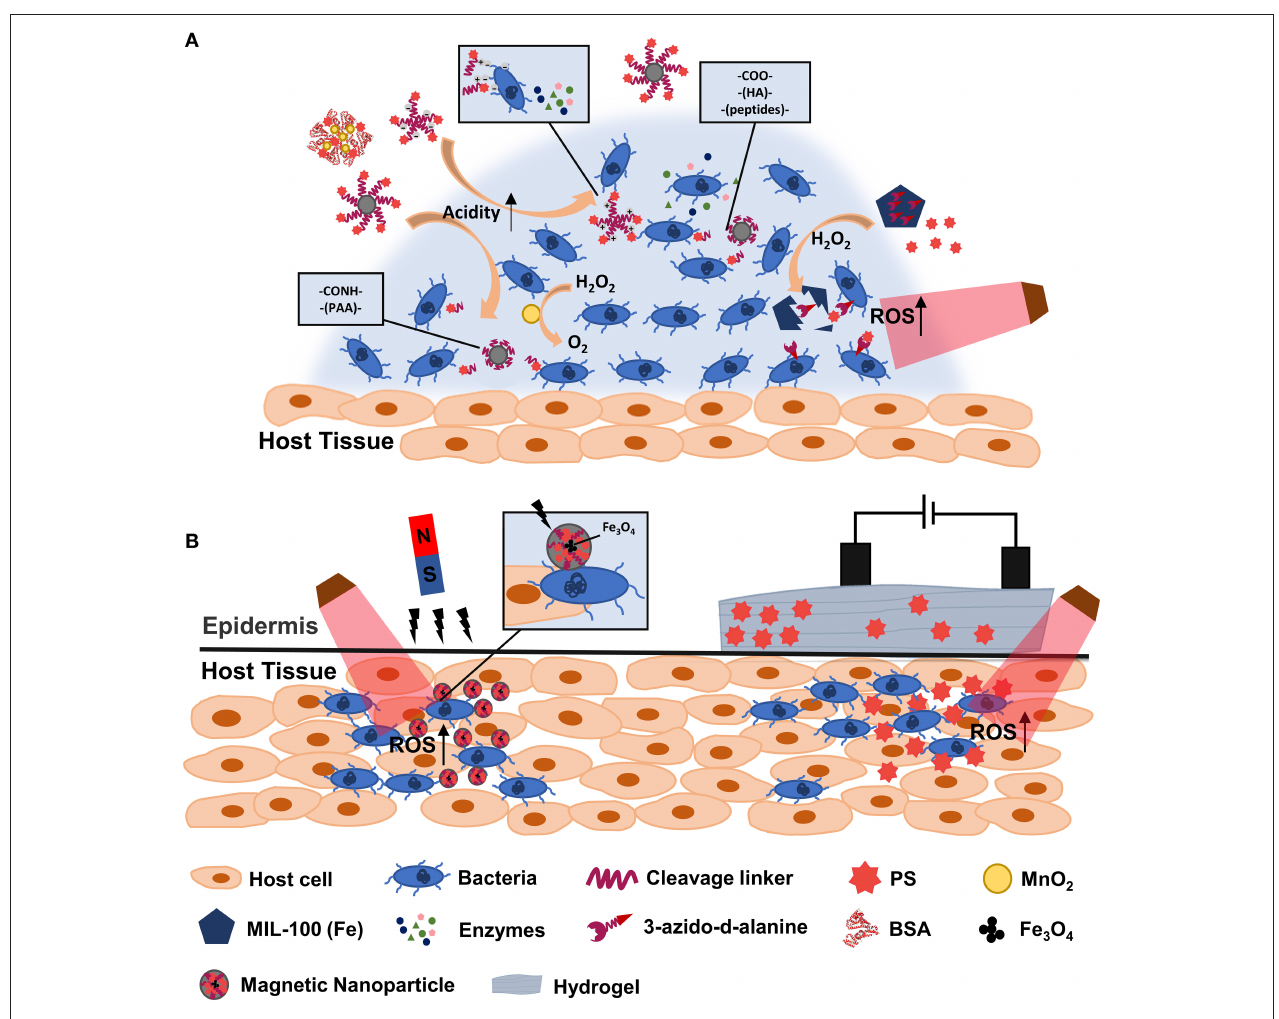
FIGURE 1 | Scheme illustration of stimuli-responsive Nanoplatforms-Assisted PDT in fighting against bacterial infections. Internal (A) and external (B) stimuli-responsive platform assisted PDT are showed. PAA, polyacrylic acid; HA, hyaluronic acid; BSA, bovine serum